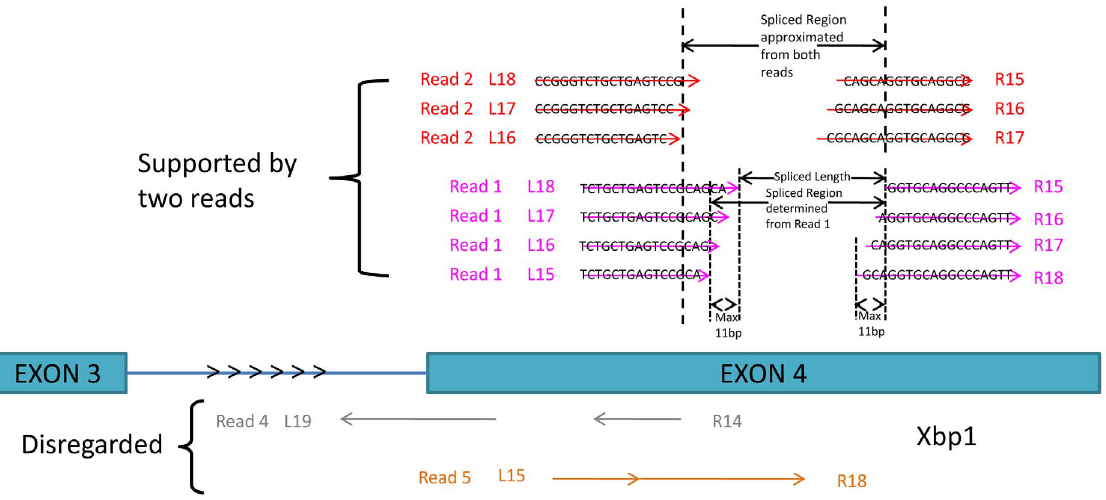
Figure 2. Illustration of a hypothetical potentially novel spliced region with two supporting reads. Below the gene are two examples that RSW would disregard: a split read pair mapped to the incorrect strand (gray) and a split read pair mapped with a 0 or 1 bp gap (orange).